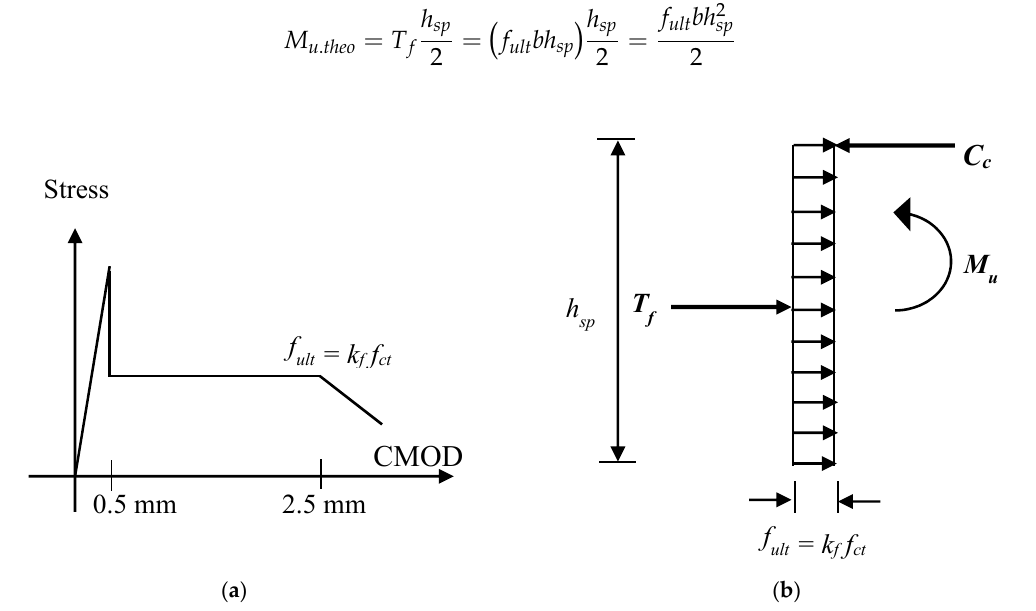
Figure 10. ( a ) Modified stress-crack opening constitutive law, ( b ) Stress and forced distribution at ultimate moment based on modified model.